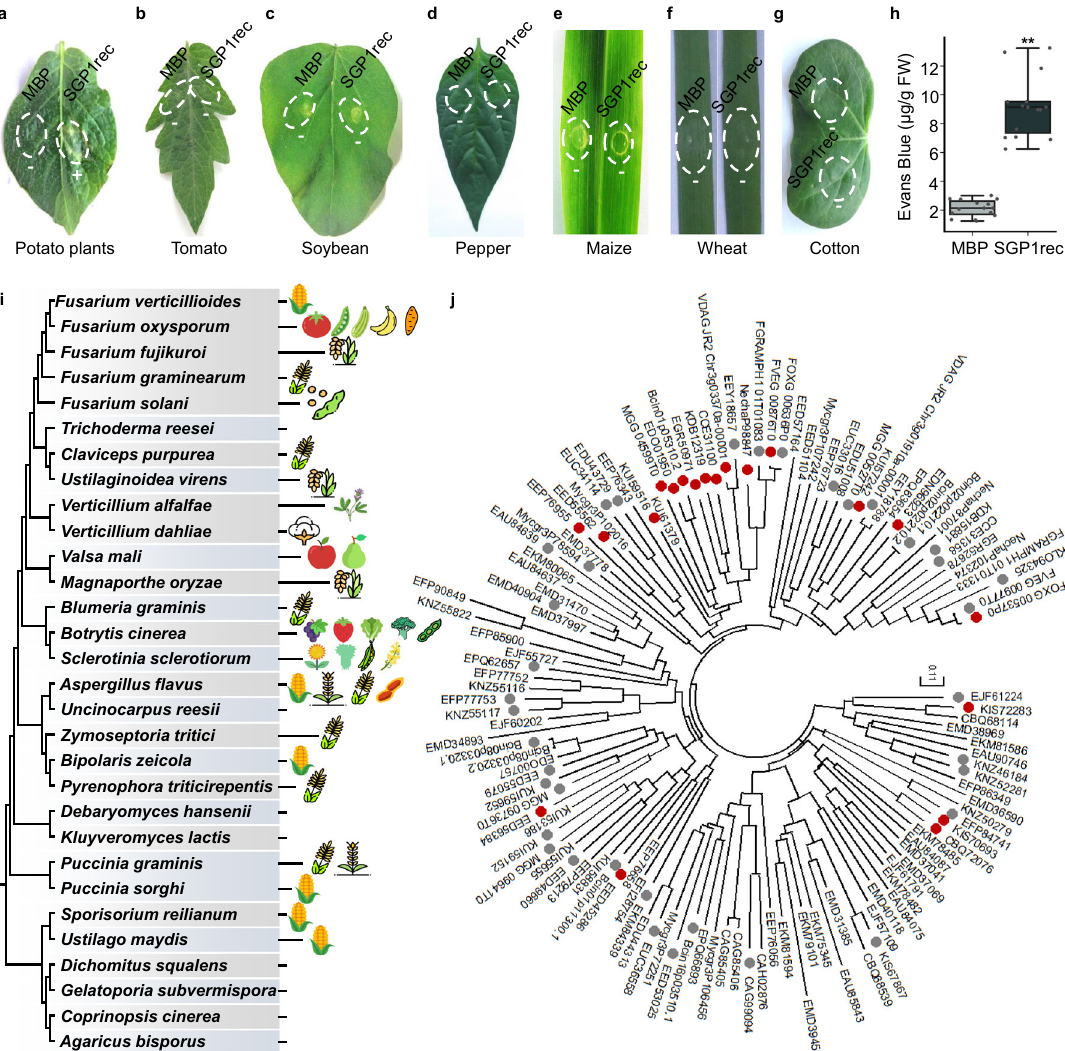
Fig. 2 Speci fi city of the host response to SGP1 and wide distribution of SGP1 homologs across fungal species. a – h Cell death responses in other plant species triggered by exposure to 1 μ M SGP1rec or MBP control. a – g Representative leaves are shown for potato plants ( a ), tomato ( b ), soybean ( c ), pepper ( d ), maize ( e ), wheat ( f ), and cotton ( g ). Data were obtained from three independent experiments, with 10 plants of each species per experiment (Supplementary Data 3). Dotted circles indicate in fi ltration area. The plus symbol ( + ) indicates that the cell death phenotype was observed, and the minus symbol ( − ) indicates the absence of a clear cell death phenotype. h Cell death induced by SGP1rec in rice suspension cells. Cell death was quanti fi ed by detection of Evans Blue signal released from rice suspension cells ( μ g/g) after treatment with SGP1rec or MBP. Data were obtained from fi ve independent experiments, with three replicates in each experiment. In box plots, whiskers indicate the minimum and maximum values, the line indicates the median, the box boundaries indicate the upper (25th percentile) and lower (75th percentile) quartiles. ** P < 0.01, two-sided t -test. i Distribution of SGP1 across fungal species. The fungal species include both plant pathogenic and non-pathogenic fungi. Left, Maximum-Likelihood phylogenetic tree of fungal species which contain the Ser-Thr-rich GPI-anchored domain, reconstructed using PhyML v3.0 based on single-copy orthologs (Supplementary Data 5). Right, representative hosts of the corresponding pathogens. Image credit: https://www. fl aticon.com or https://icons8.com/icons. j Phylogeny of SGP1 and 123 related sequences from selected fungal species (Supplementary Data 2 and 4). The proteins that induce cell death in N. benthamiana are indicated by a red dot and those that do not are indicated by a gray